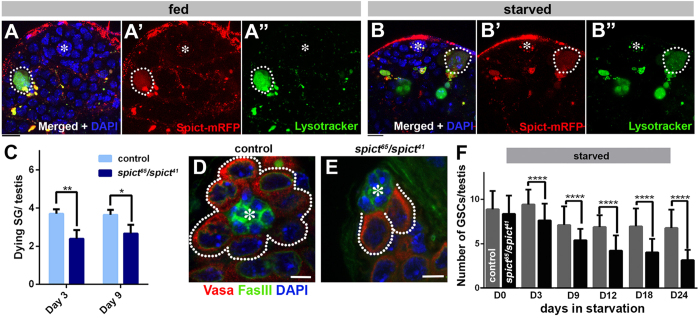
spict is required for SG death and GSC maintenance during protein starvation.(A,B) Localization of Spict-mRFP (spict-gal4 > UAS-spict-mRFP) in an adult testis under fed (A) and protein-starved conditions (B). A dotted line encircles dying SG; Bar: 10 μm. (C) Quantification of SG death in control (spict41/CyO) and mutant (spict65/spict41) testes upon 3 and 9 days of protein starvation. The data are shown as mean ± s.d. N > 120 testes were scored for each data point. *P < 0.05, **P < 0.005 (Student’s t-test, two-tailed). (D,E) Examples of the apical tip after 24 days of protein starvation in control (D) and spict65/spict41mutant (E) testes. GSCs are indicated by dotted lines. The hub is indicated by asterisks. Bar: 5 μm. (F) GSC number in control (gray) and spict65/spict41mutant (black bar) testes during protein starvation. The data are shown as mean ± s.d. N = 15 testes were scored for each data point. (****P < 0.00005, Student’s t-test, two-tailed).